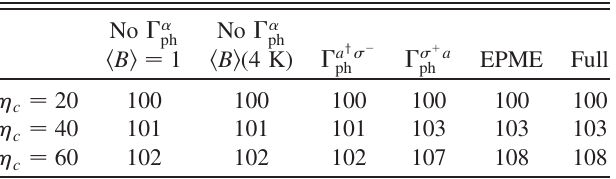
TABLE IV. Dependence on the x FWHM of the power- broadened PL intensity of a QD-driven cavity-measured system ¼ 3 meV ), on the two phonon Lindblad processes, (cid:3) (cid:1) þ ( (cid:1) cx , at T ¼ 4 K , for various values of (cid:4) (cid:3) (cid:1) (cid:1) ph